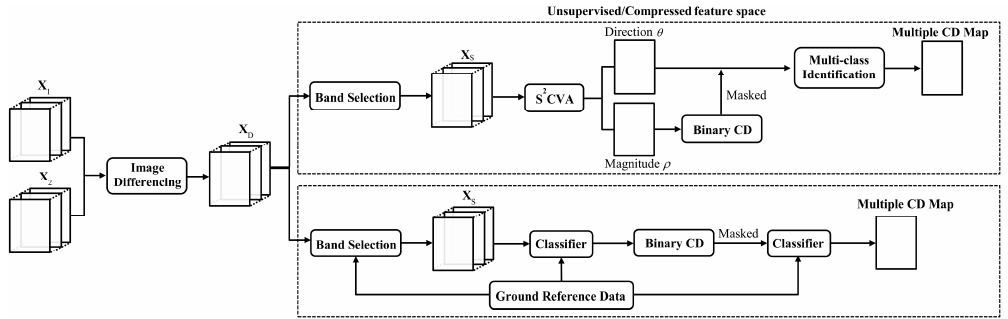
Figure 1. Block scheme of the proposed HSI-CD approaches based on BS-DR. Figure 1 . Block scheme of the proposed HSI-CD approaches based on BS-DR.